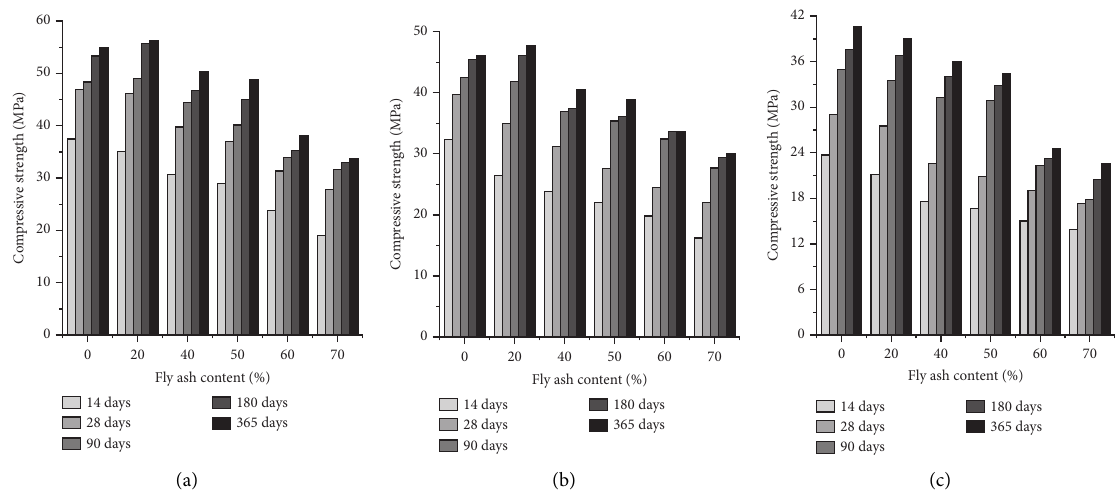
Figure 3: Compressive strength versus different fly-ash content: (a) w/b, 0.35; (b) w/b, 0.40; (c) w/b, 0.45.